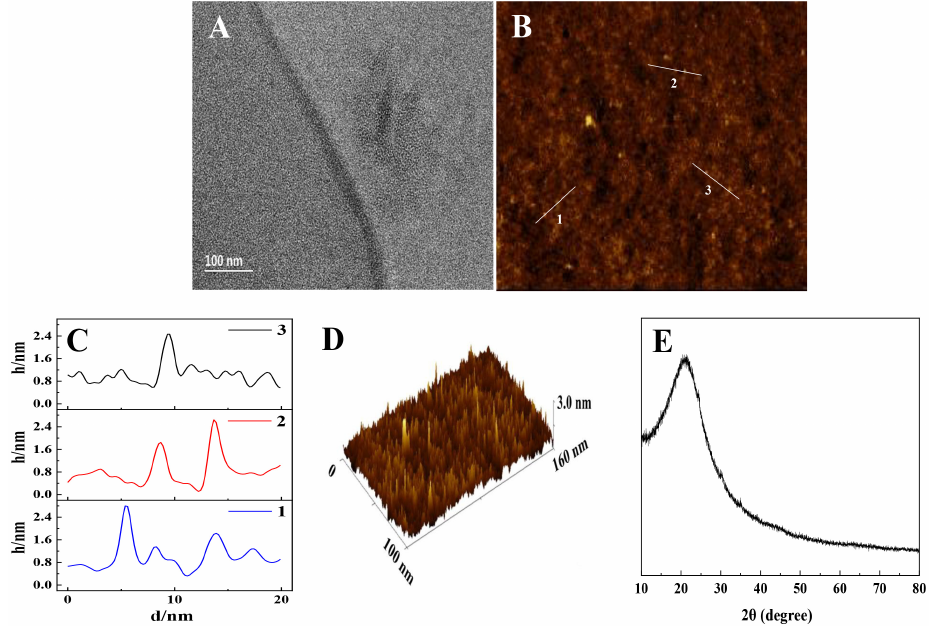
Figure 2. ( A ) TEM, ( B – D ) AFM, and ( E ) XRD pattern of the PEI@CNDs. The XRD pattern displays a wide diffraction peak at 2 θ = 21.1°, corresponding to the (002) crystal plane of the carbon-based material [49,50], indicating that the crystallinity of the sample is low, confirming again the amorphous nano-cluster structures.